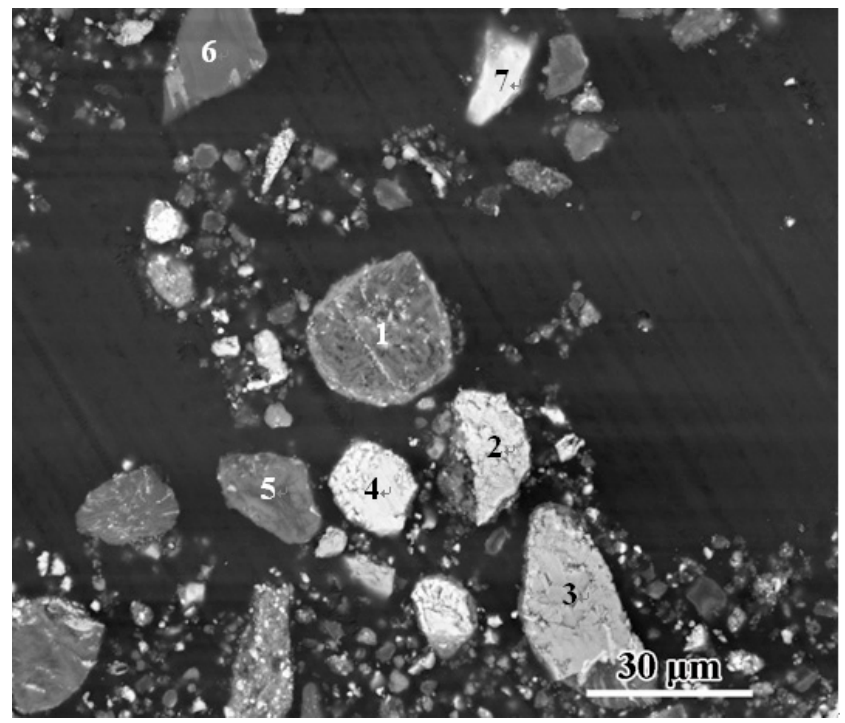
Figure 4. The SEM images of leached slag residue with microwave (85 °C) for 60 min.